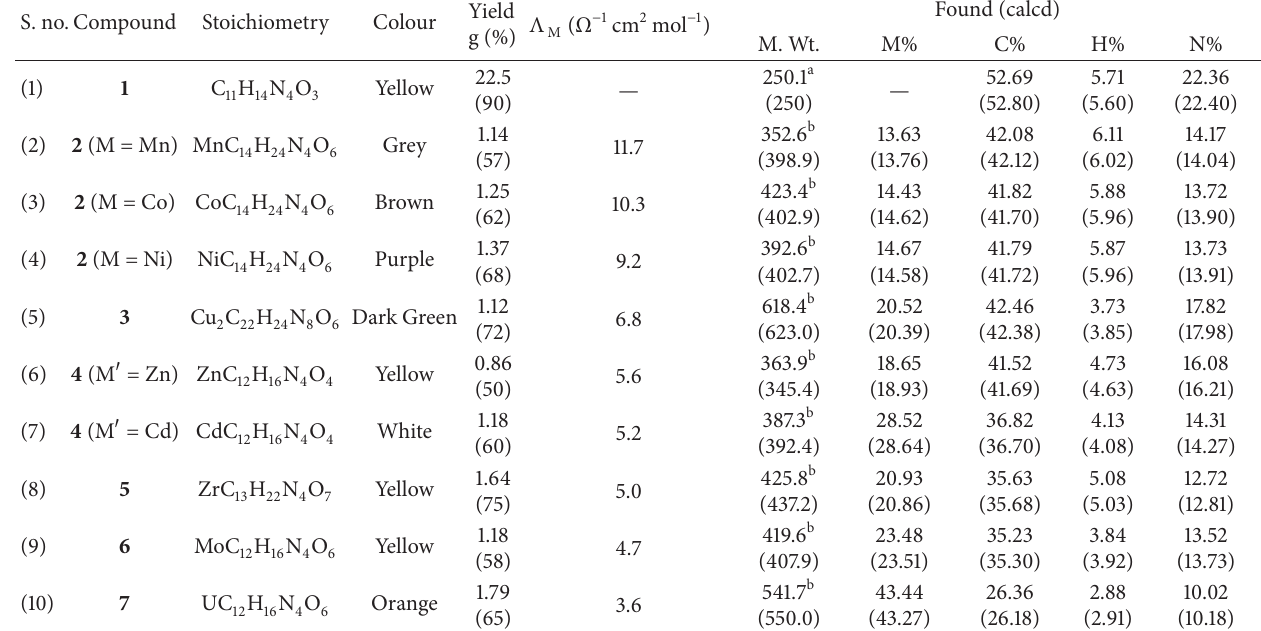
Table 1: Analytical, colour, molar conductance ( Ω − 1 cm 2 mol − 1 ), mass spectral, and molecular weight data of compounds. S. no.